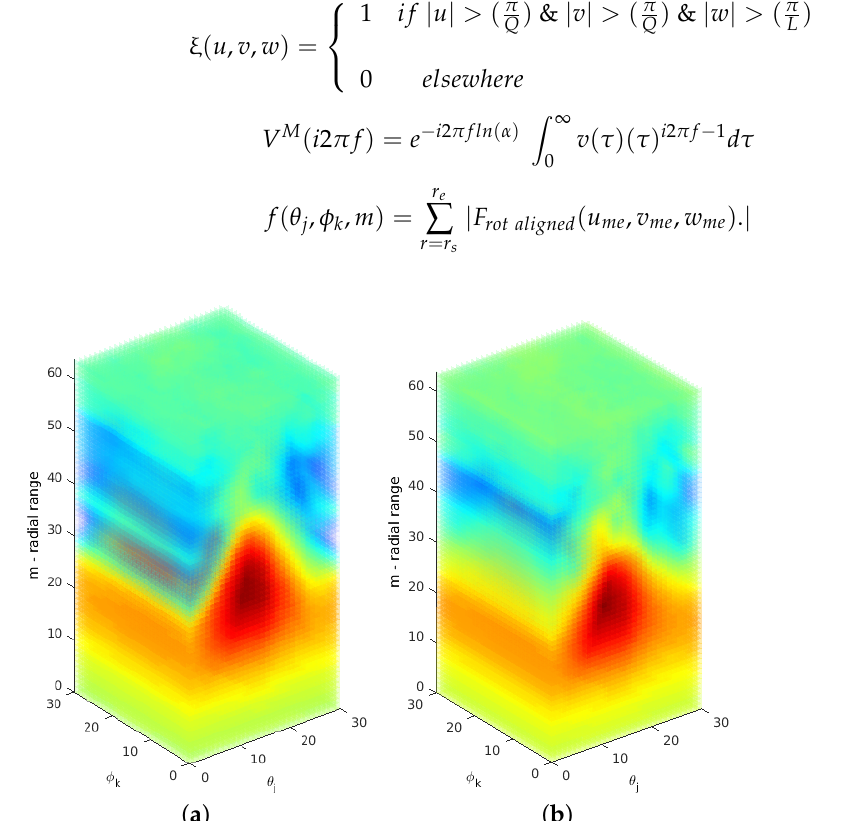
Figure 3. Radially logarithmically resampled descriptor functions. The small shift used for scale parameter determination is visible comparing the functions for scan 1/2. ( a ) Descriptor function using an oversampling representation—scan 1. ( b ) Descriptor function using an oversampling representation—scan 2.